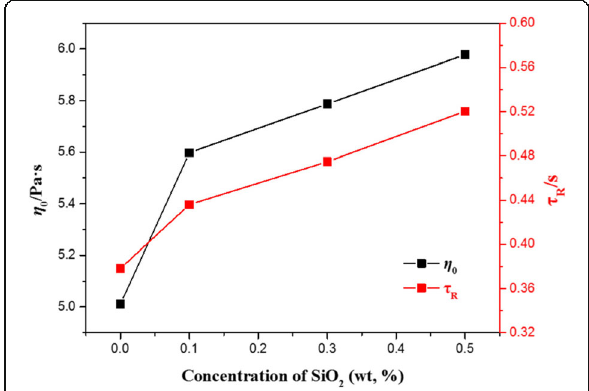
Fig. 4 Dependences of the zero-shear viscosity η 0 and the relaxation time τ R on the concentration of silica nanoparticles at 25 ° ∁